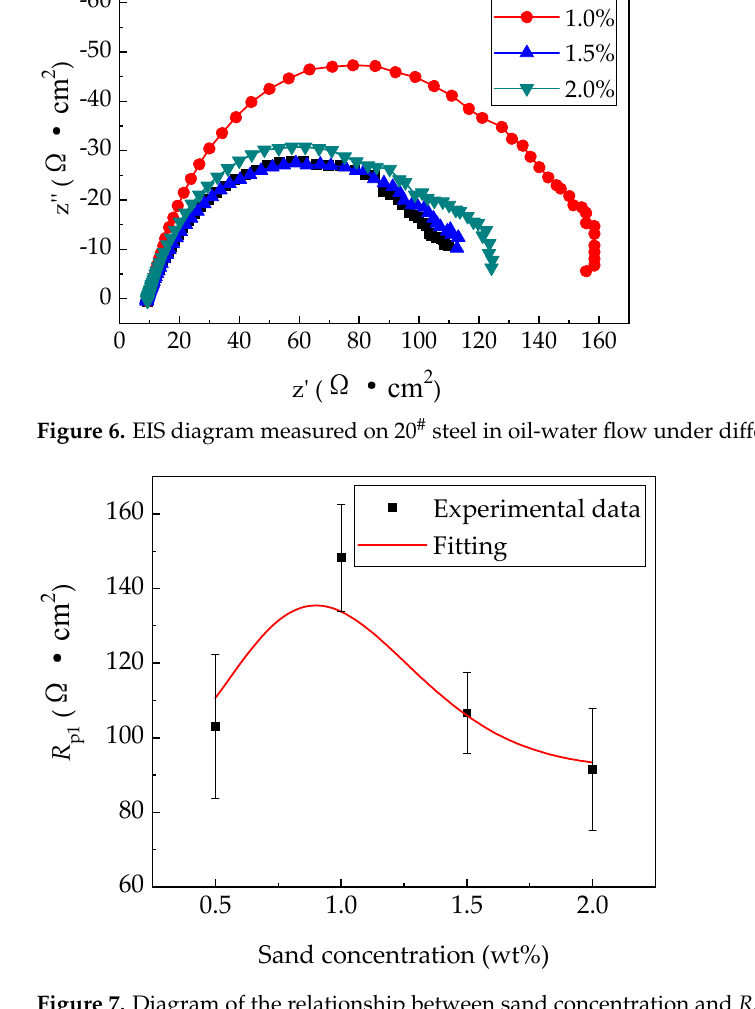
Figure 7. Diagram of the relationship between sand concentration and R p1 in oil-water flow.